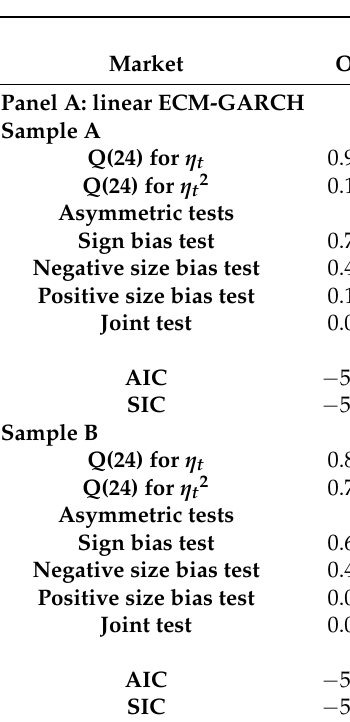
Table A4. Model evaluation for cross-border futures